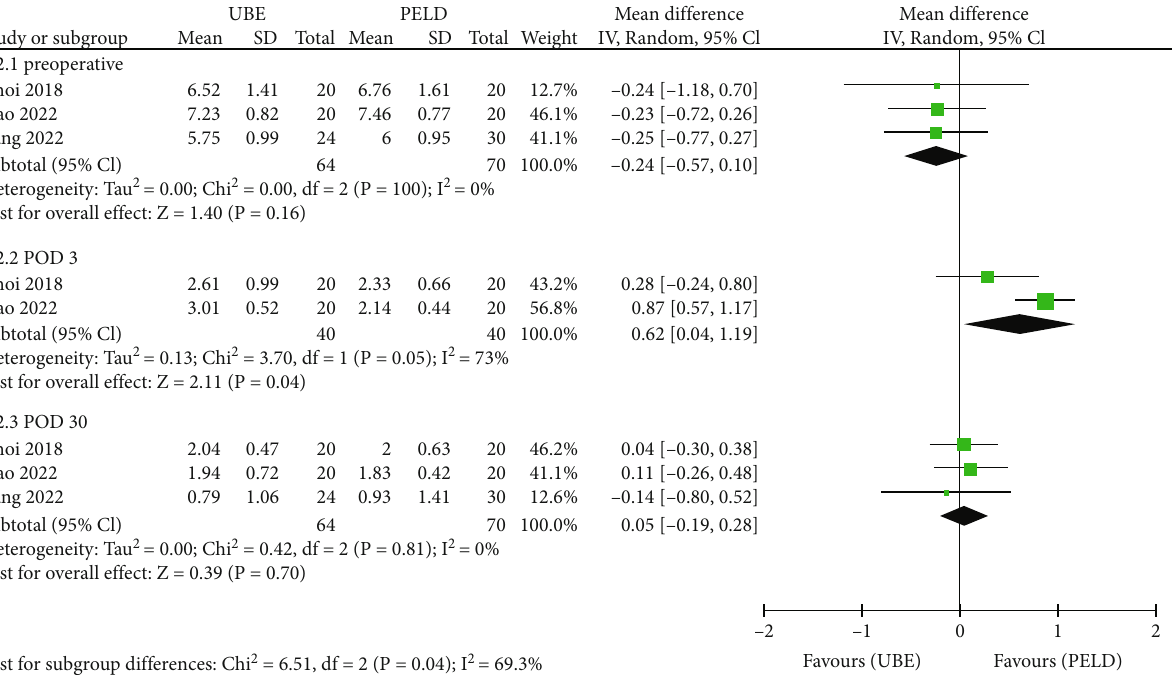
Figure 4: Forest plots for VAS of back pain at preoperative/postoperative 3 days/postoperative 30 days.